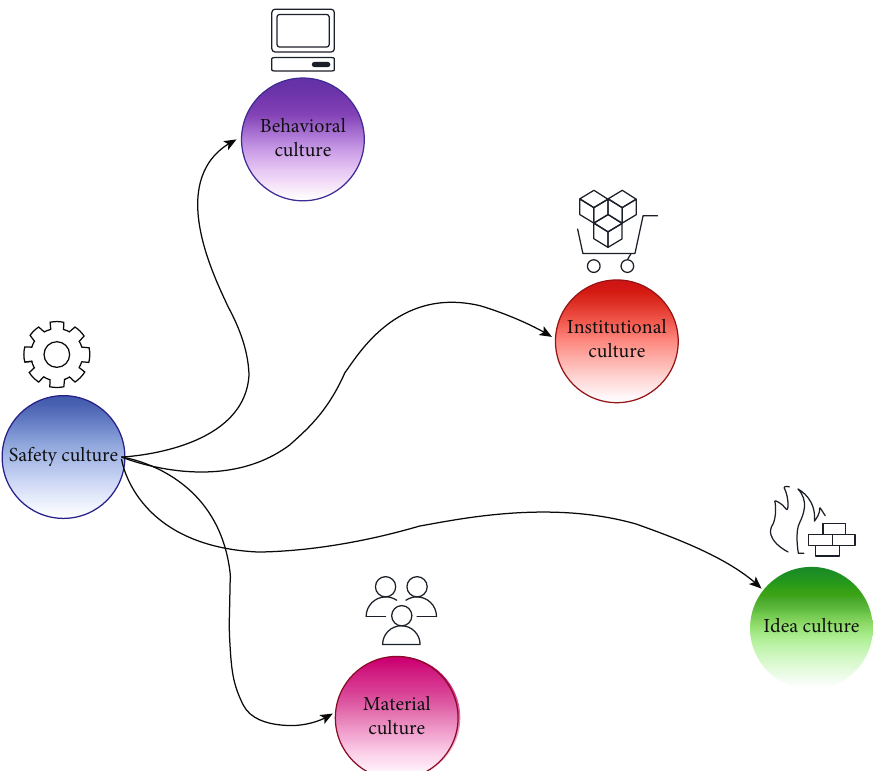
Figure 1: Composition of university safety